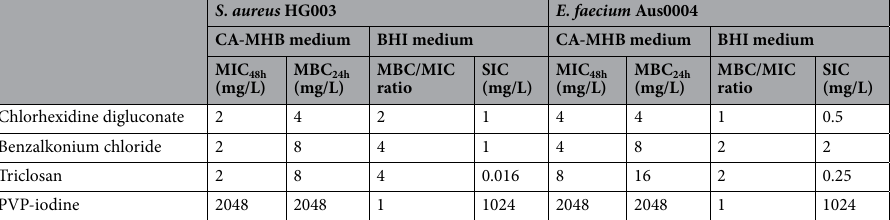
Table 1. Antimicrobial activities of chlorhexidine digluconate, benzalkonium chloride, triclosan and PVP- iodine on S. aureus HG003 and E. faecium Aus0004. CA-MHB: cation-adjusted Mueller–Hinton broth; BHI: Brain Heart Infusion; MIC 48h : minimal inhibitory concentrations after 48 h of incubation; MBC 24h : minimal bactericidal concentrations after 24 h of incubation; SIC: sub-inhibitory